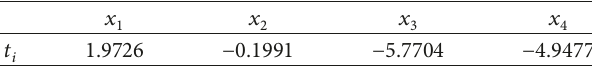
Table 3: Test statistics 𝑡 𝑖